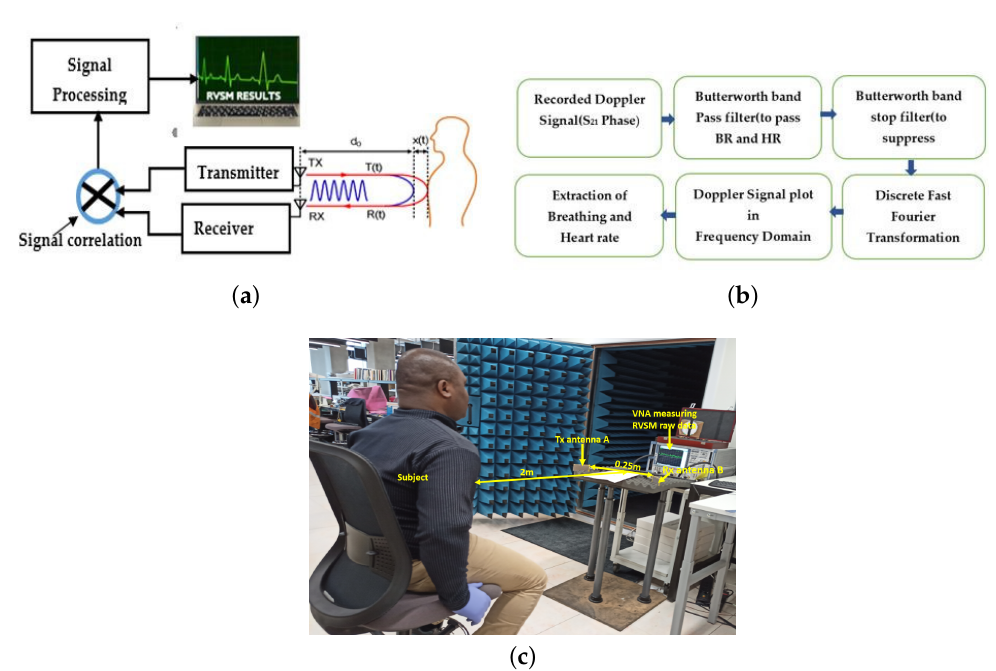
Figure 13. Demonstration of the RVSM experiment setup